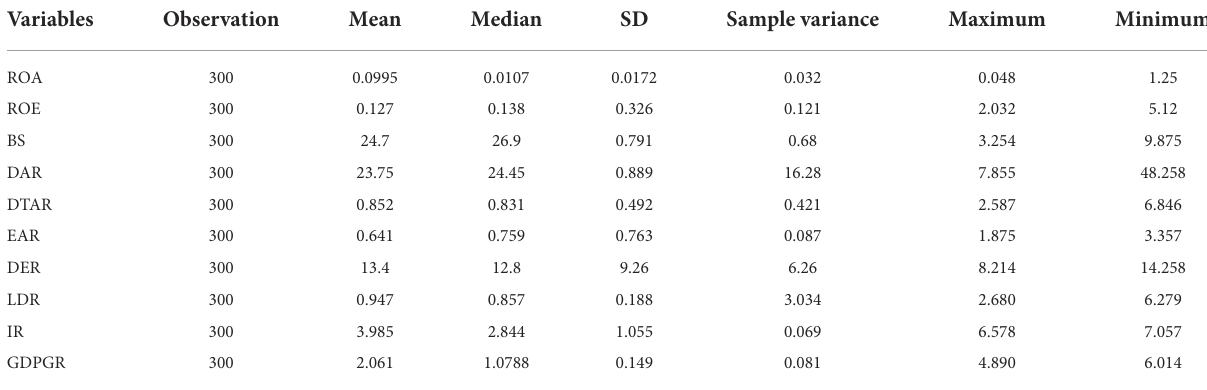
TABLE 4 Descriptive Statistics for both Bangladesh and India